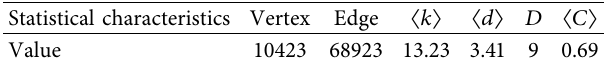
Table 4: The main statistical characteristics of the complex network of traditional Chinese cultural